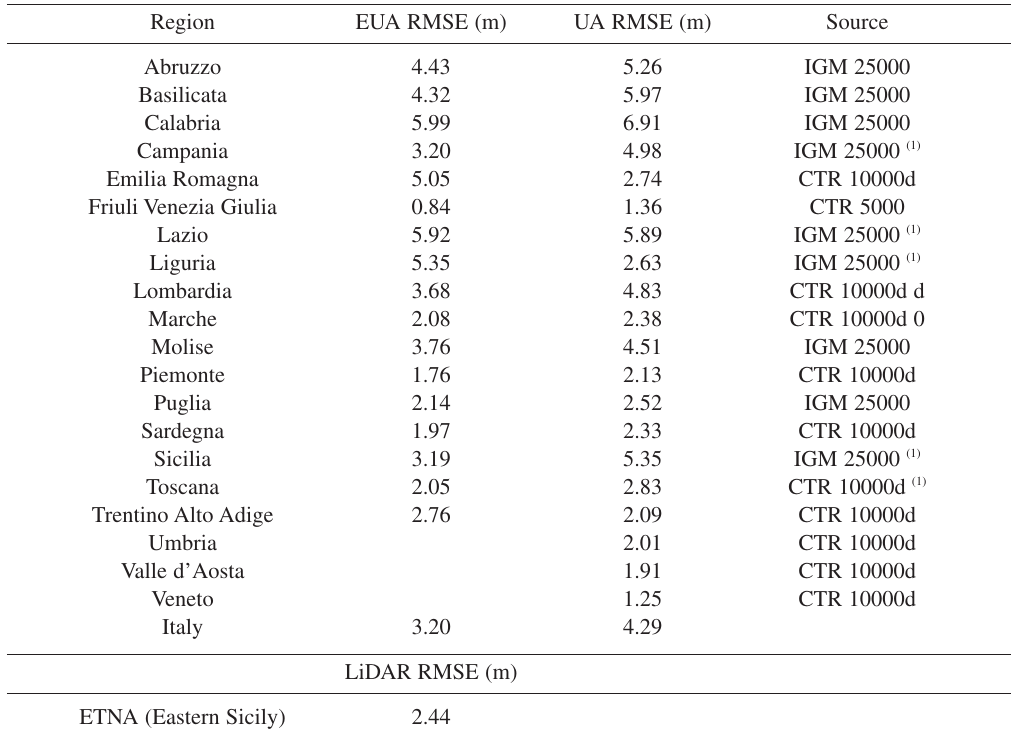
Table III. The elevation RMSE of the TIN for the 20 Regions of Italy.